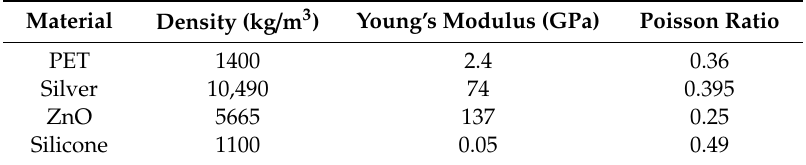
Table 2. Mechanical properties of materials used in the FEM models of pVEH microdevice. Material Density (kg / m 3 ) Young’s Modulus (GPa) Poisson Ratio Silicone 1100 0.05 0.49 10,490 1100